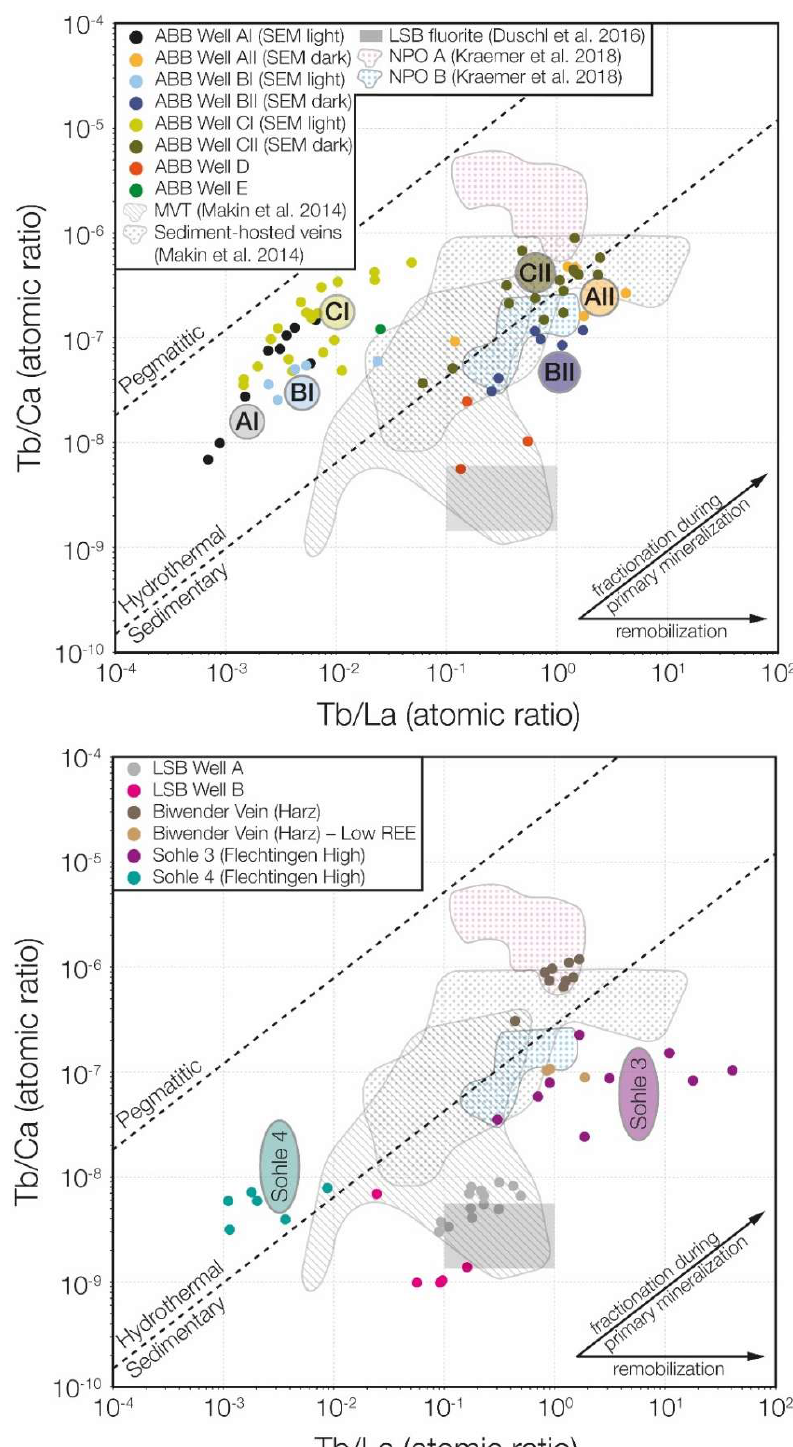
Figure 9. Tb/La versus Tb/Ca atomic ratio diagram after Möller et al. [33] for fluorite from the ABB, LSB, Biwender Vein (Harz), and Flechtingen High. For reference, fields compiled and established by Makin et al. [28], Duschl et al. [11], and Kraemer et al. [43]—North Pennine Ore Field (NPO), Alston Block (A) and Askrigg Block (B) are plotted. Labels, groupings and colours in the diagram (e.g., AI, Sohle 3) correspond to sample populations shown in Figures 4 and 5. See text for discussion.